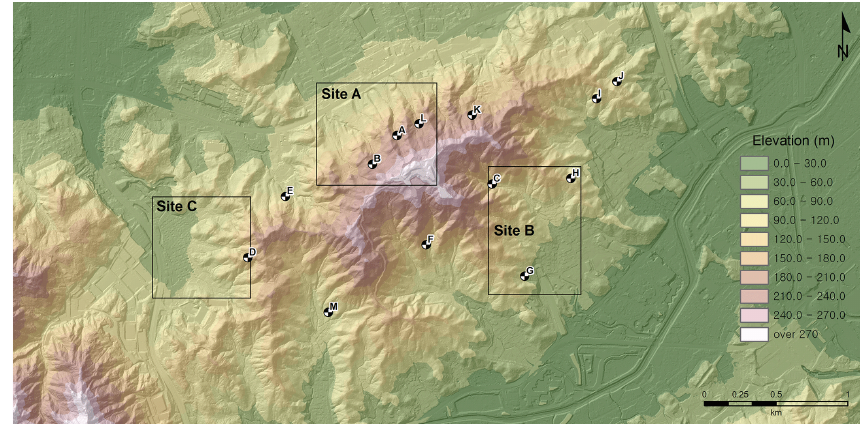
Figure 2. Location of the study area. Major landslide areas are also indicated. The position of each landslide area is calculated as a mean cen- ter for the individual landslide initiation zone: (A) Raemian Apartment, (B) Sindonga Apartment, (C) Hyunchon-maul, (D) Jeonwon-maul, (E) Bodeok-sa, (F) Songdong-maul, (G) Umyeonsan Tunnel, (H) Educational Broadcasting System buildings, (I) Gwanmun-sa, (J) Gangnam Church, (K) Seoul Arts Center, (L) Deokwoo-am, and (M) Dwit-gol. Areas outlined by black rectangles are shown in Figs. 10 to 12. The geographic coordinates of the landslide area A are 37.474013 (latitude) and 127.006552 (longitude) in decimal degrees.